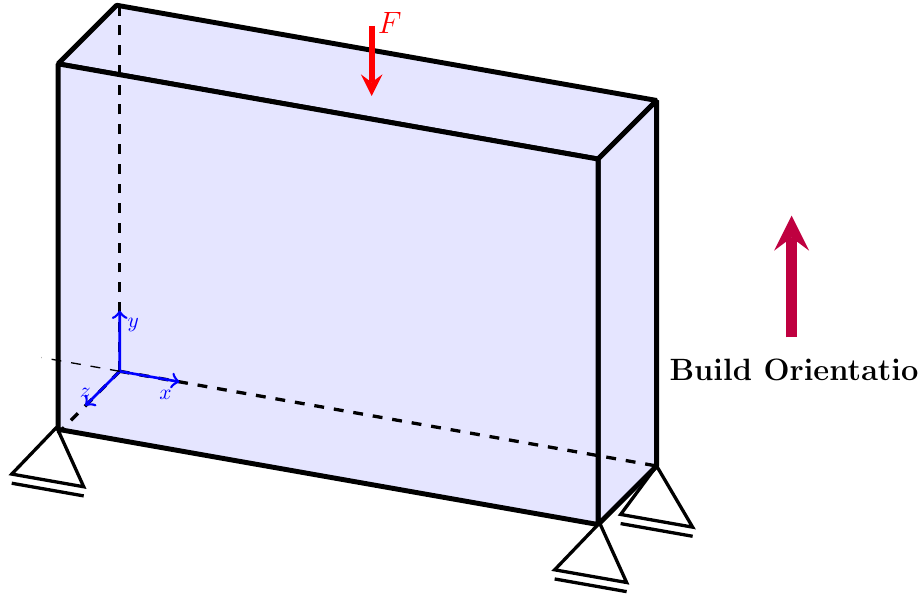
Figure 4. Design domain of a simply supported deep